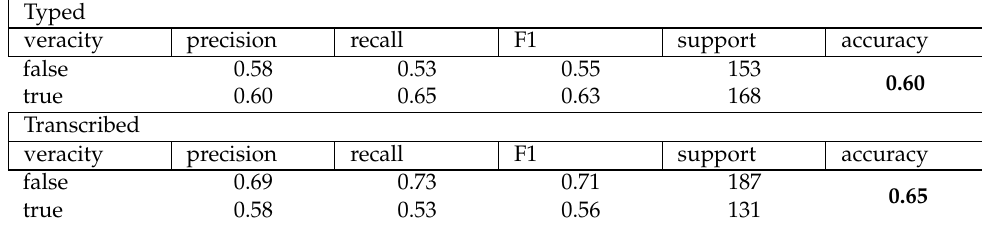
Table 6. Automated recognition of veracity as a text classification problem. Averages of 20-fold